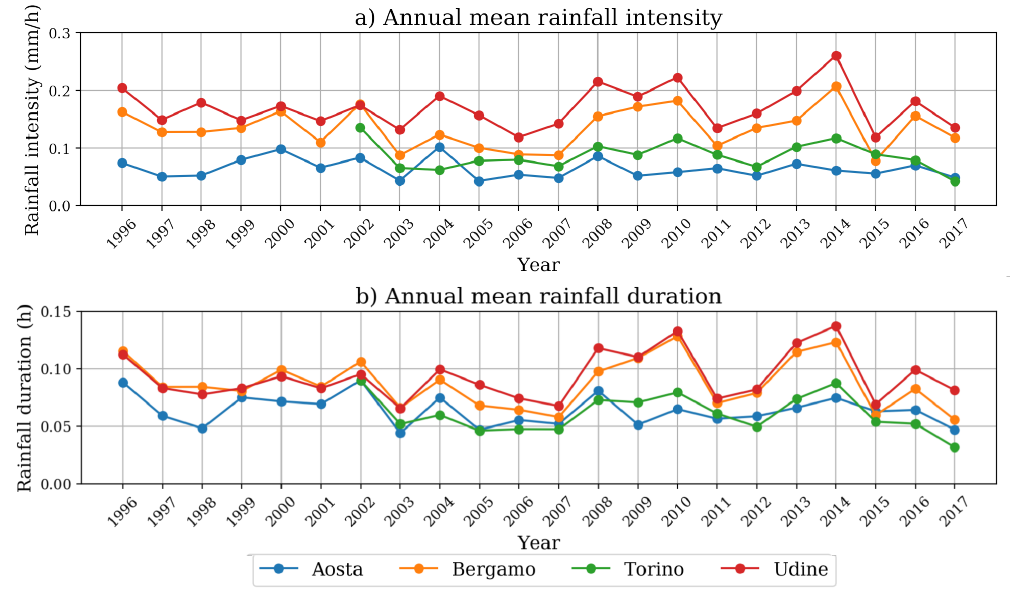
Figure 1. Annual mean rainfall intensity ( a ) and annual mean rainfall duration ( b ) for the four stations